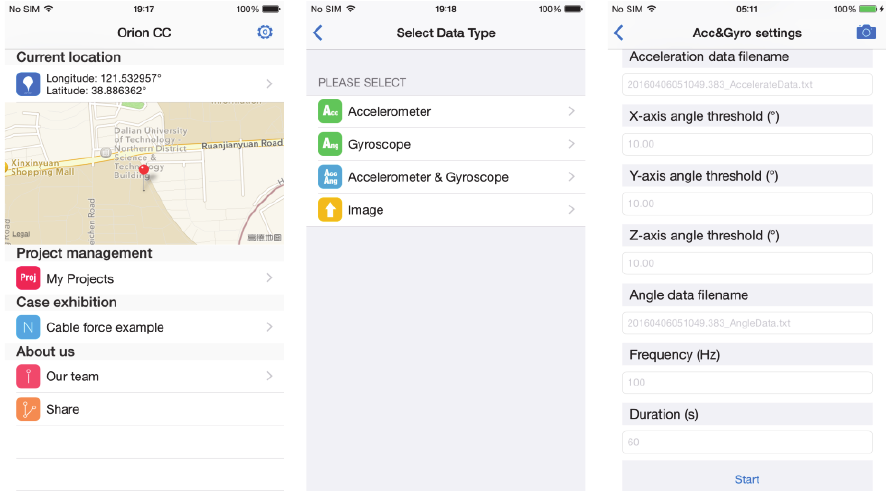
Figure 4: Main interface of Orion-CC.